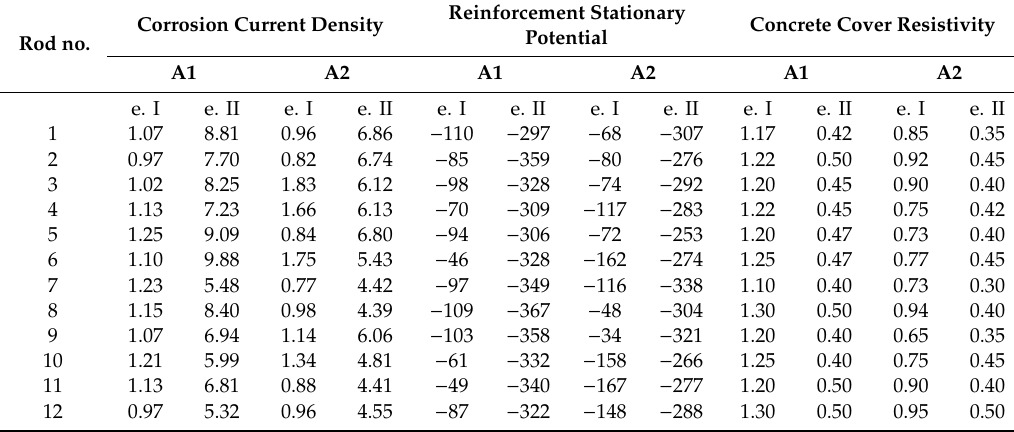
Table 3. Summary of measurement results from the two stages of tests for each tested rod on the selected measurement